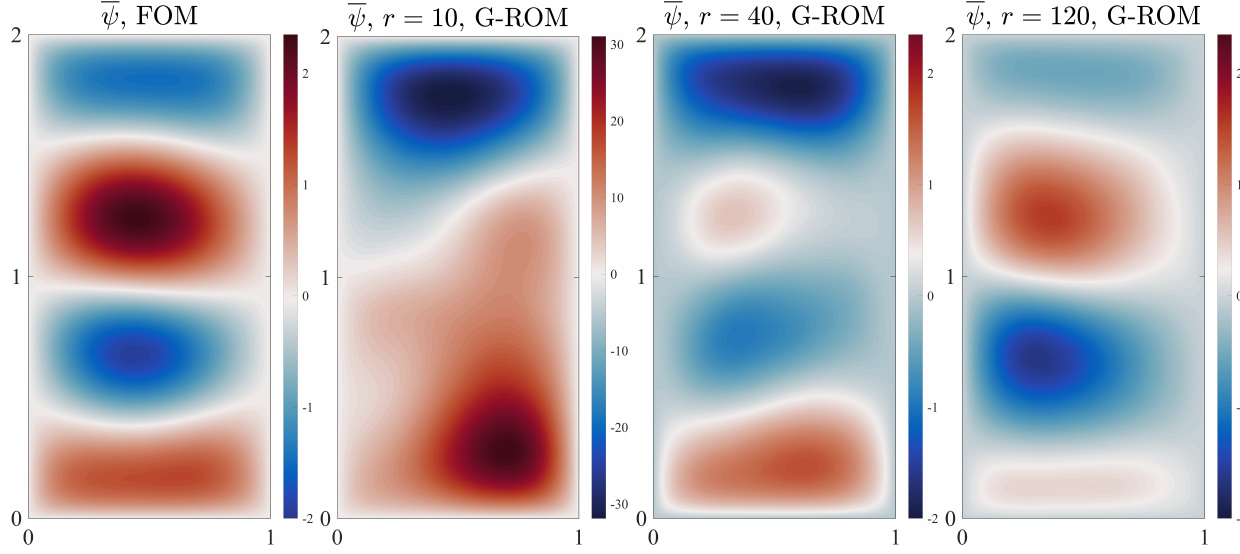
Figure 10. Resolved, predictive regime. Time-averaged streamfunction, ψ , for FOM and G-ROM with r = 10,40, and